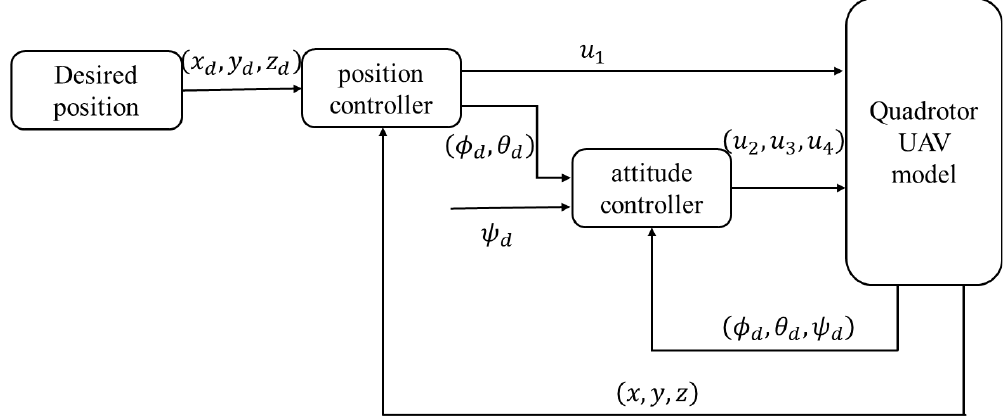
Figure 2. Control system of the quadrotor UAV based on SMC.